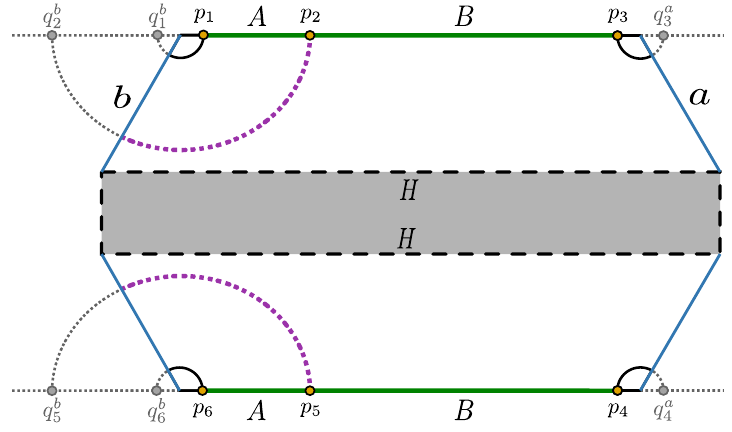
Figure 4 . Dominant channel for the S R . EWCS is denoted by the violet dotted curve. Here q b = r I − (cid:15) is the mirror image of the point p 1 = r I + (cid:15) with respect to the b -boundary at p I = r I . 1 Similarly, q a = r O + (cid:15) is the mirror image of the point p 3 = r O − (cid:15) with respect to the a -boundary at 3 p O = r O . Also, q b = 2 r I − r is the mirror image of the point p 2 = r with respect to the b 2